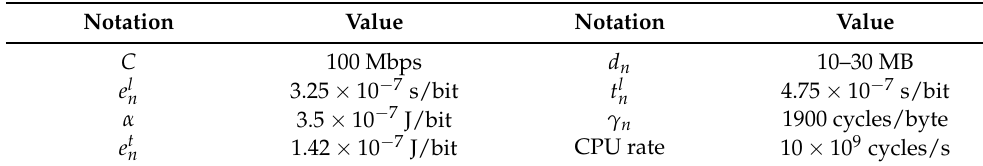
Table 2. Simulation